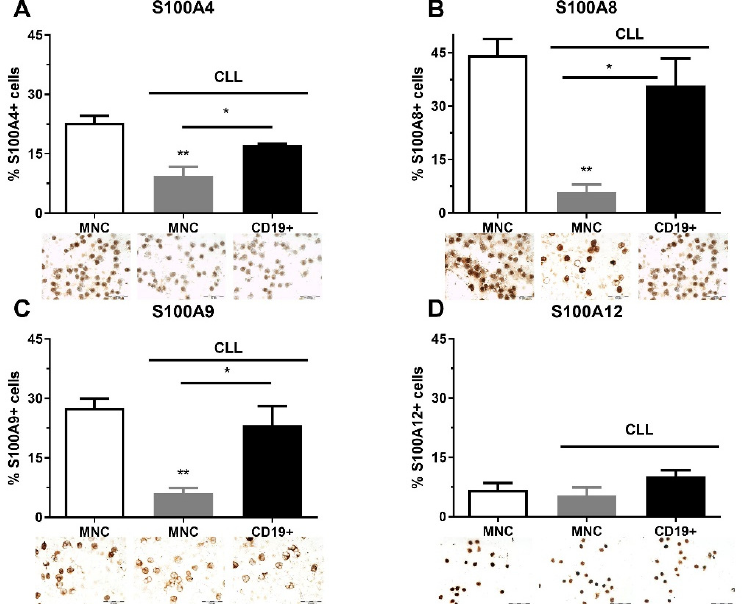
Figure 1. Level of pro-inflammatory S100As positive cells in mononuclear cells (MNCs) and CD19 + cells of peripheral blood of chronic lymphocytic leukemia (CLL). The number of ( A ) S100A4, ( B ) S100A8, ( C ) S100A9, and ( D ) S100A12 cells in MNCs and CD19 + cells of CLL. Data results are presented as mean ± SD ( n = 3–4). * p < 0.05, ** p < 0.01 versus MNCs from healthy donors.